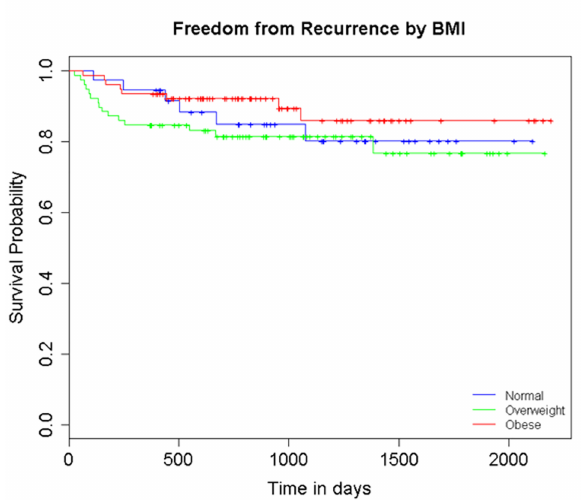
Figure 1 - Recurrence by BMI